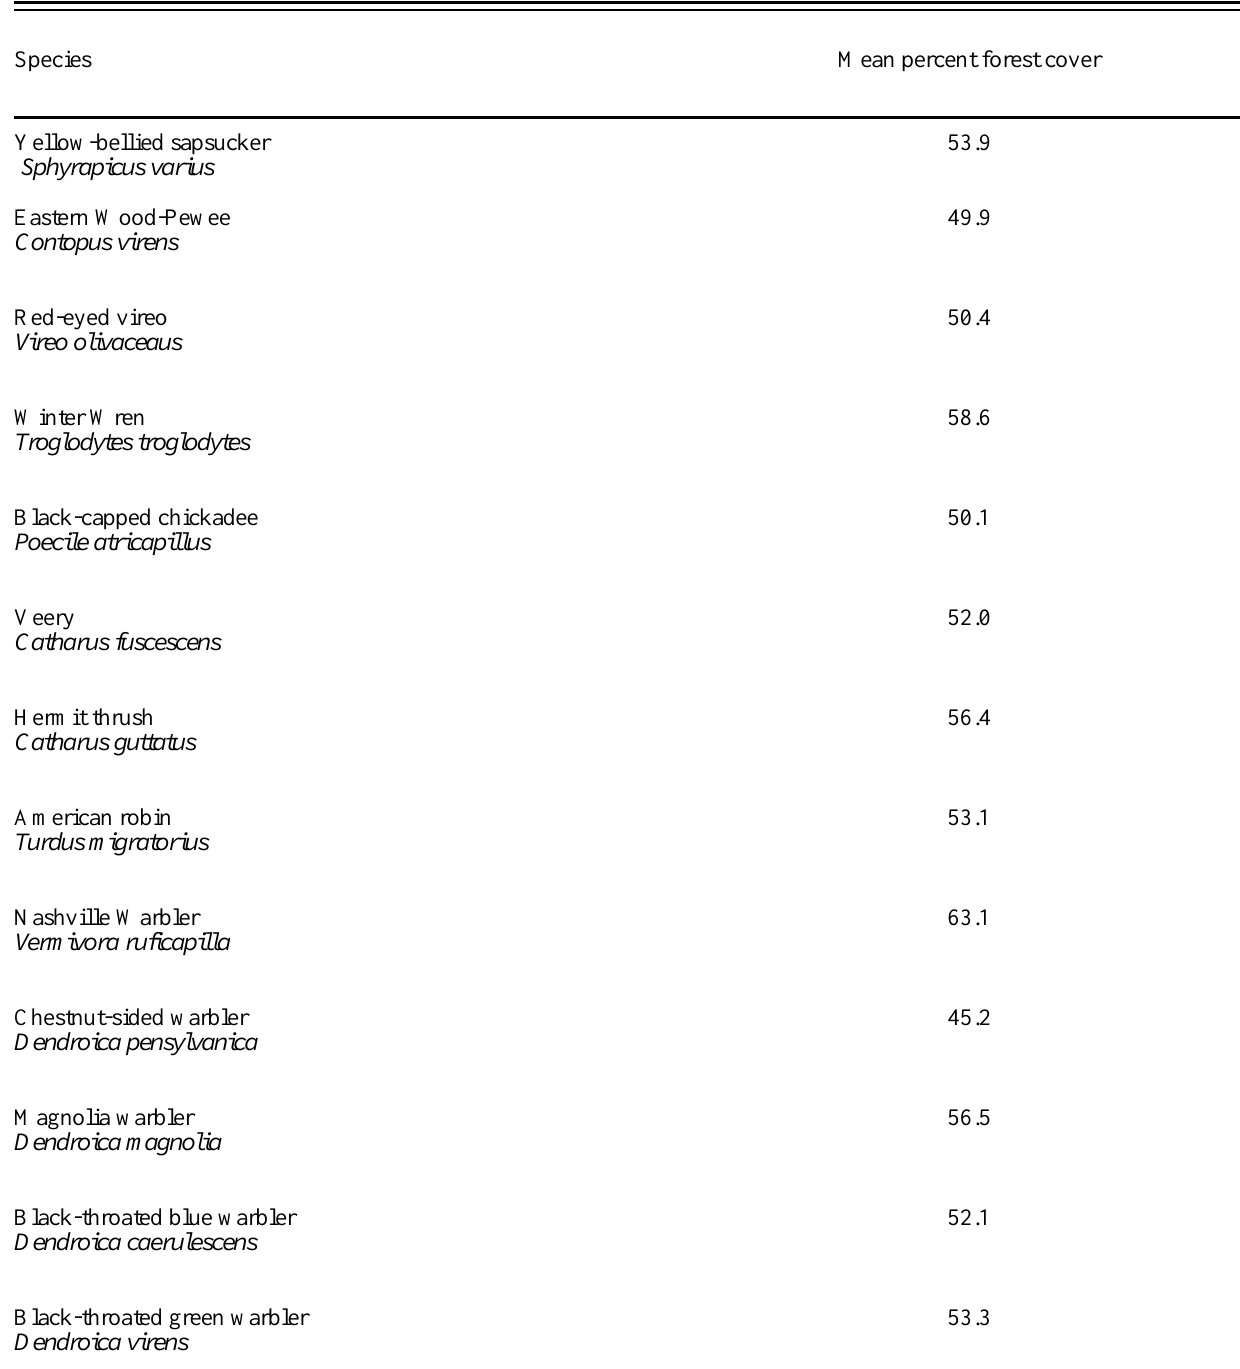
Table 4. Percent forest cover was calculated within 500-m radius circles centered on 102 point count stations. For each species, we present the mean percent forest cover around the stations where this species occurred. Data were collected in 2000 within 50 km of Quebec City (46°45’ N, 71°20’ W), Québec, Canada.